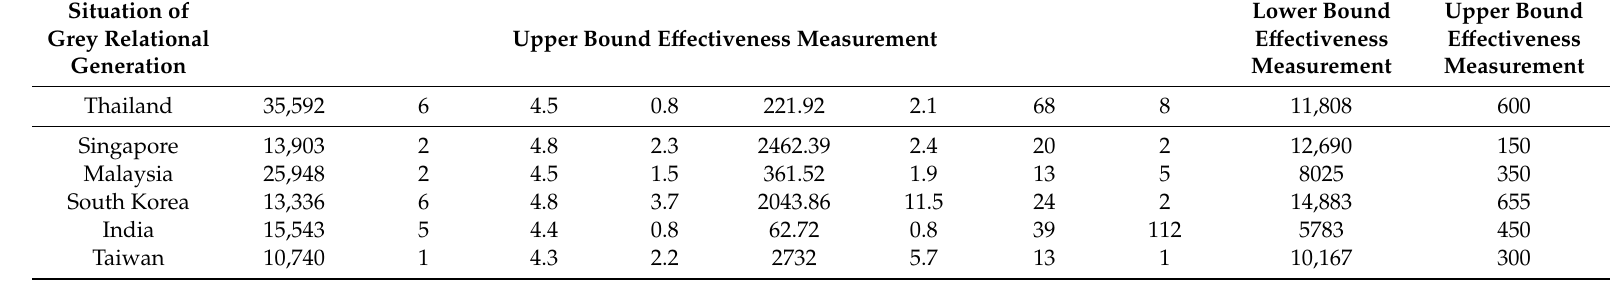
Table 3. Collected variables and situation of Grey relational